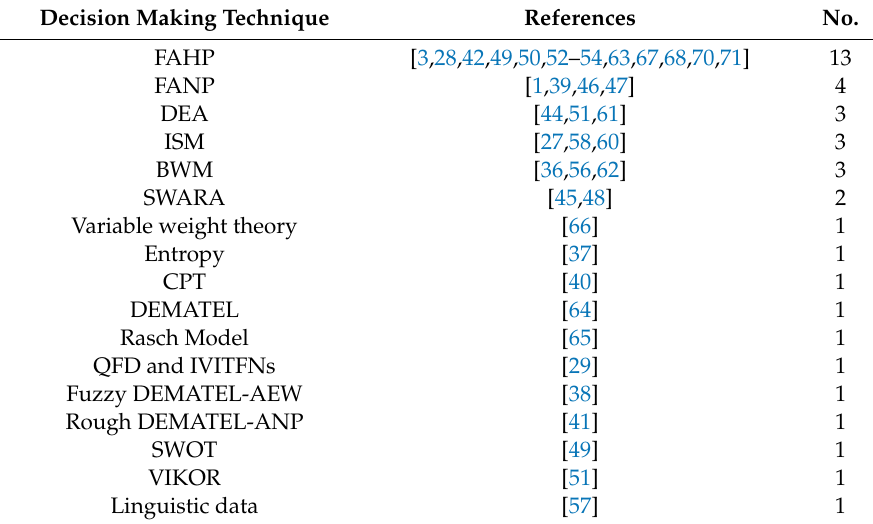
Table 7. Decision making